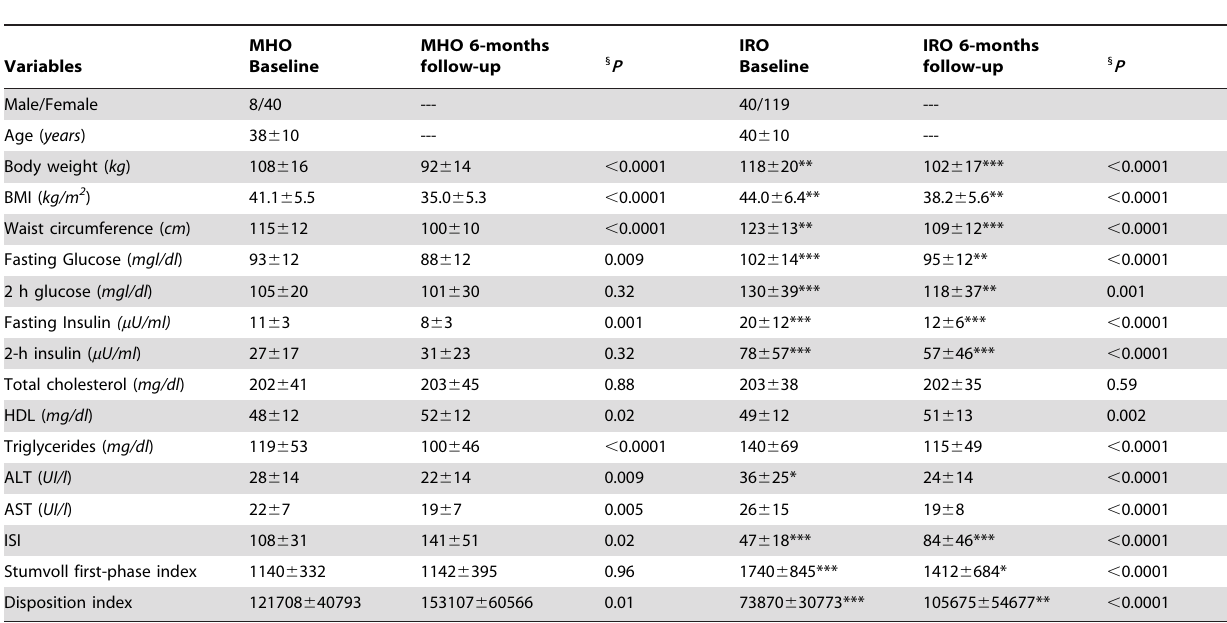
Table 1. Clinical characteristics and laboratory data at baseline and after LAGB intervention in MHO and IRO subjects.